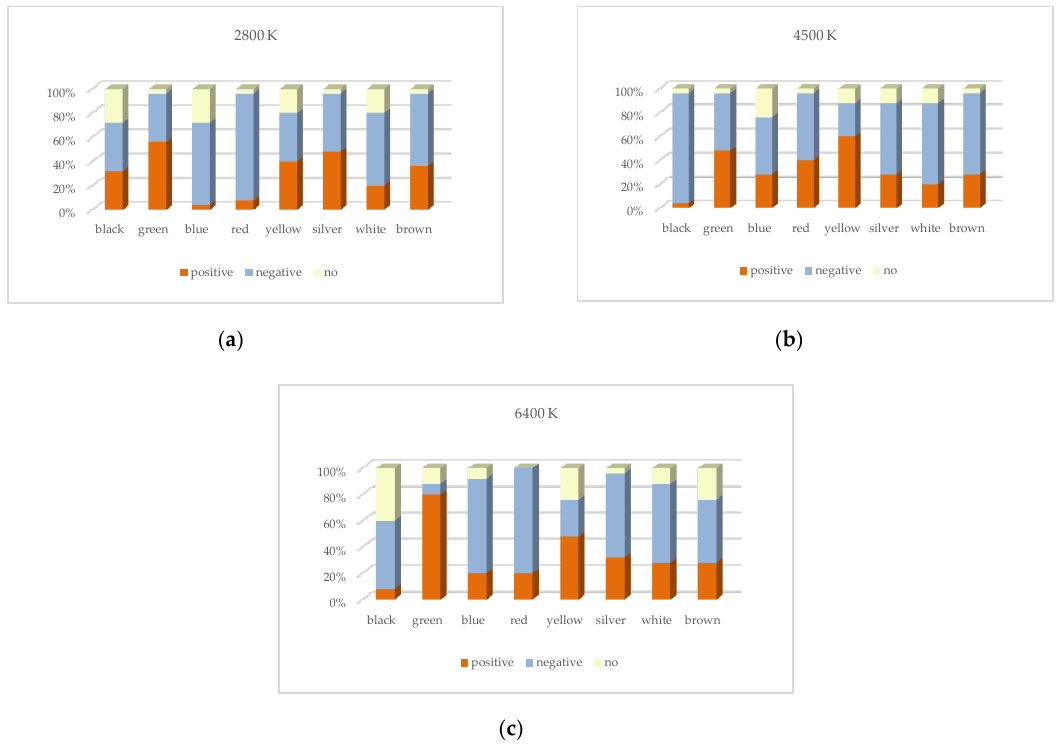
Figure 13. The probability distribution of the correlation between CRI2012 and reaction time when HP-CCT is 5700 K. ( a ) LP-CCT = 2800 K. ( b ) LP-CCT = 4500 K. ( c ) LP-CCT = 6400 K.